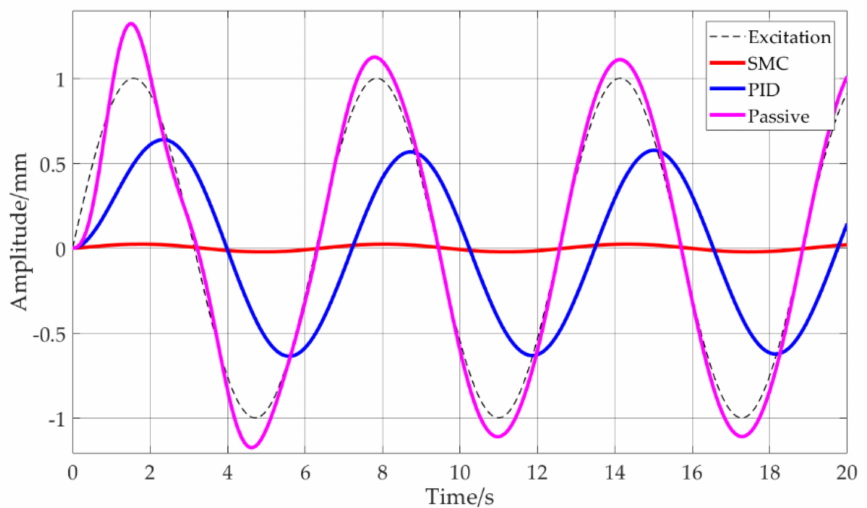
Figure 5. Comparison of the SMC, PID and the passive system under excitation of a sinusoidal signal with an amplitude of 1 mm and a frequency of 1 rad/s.